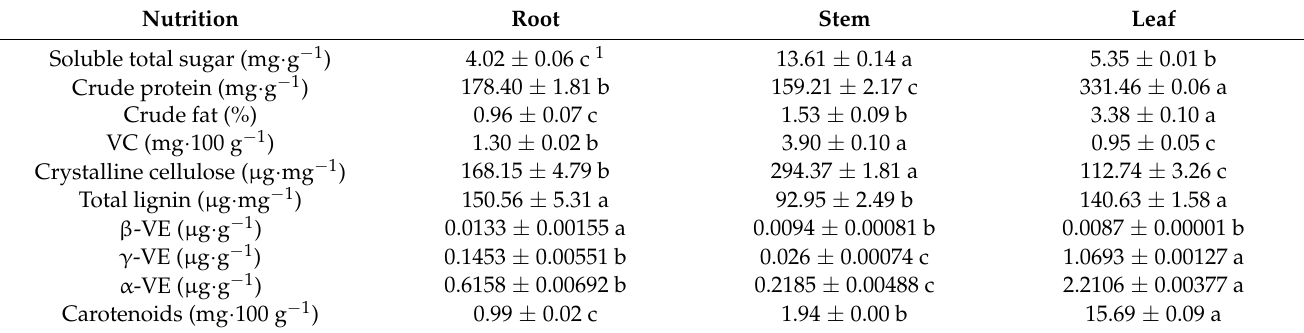
Table 5. Content of different nutrients in different tissues of water